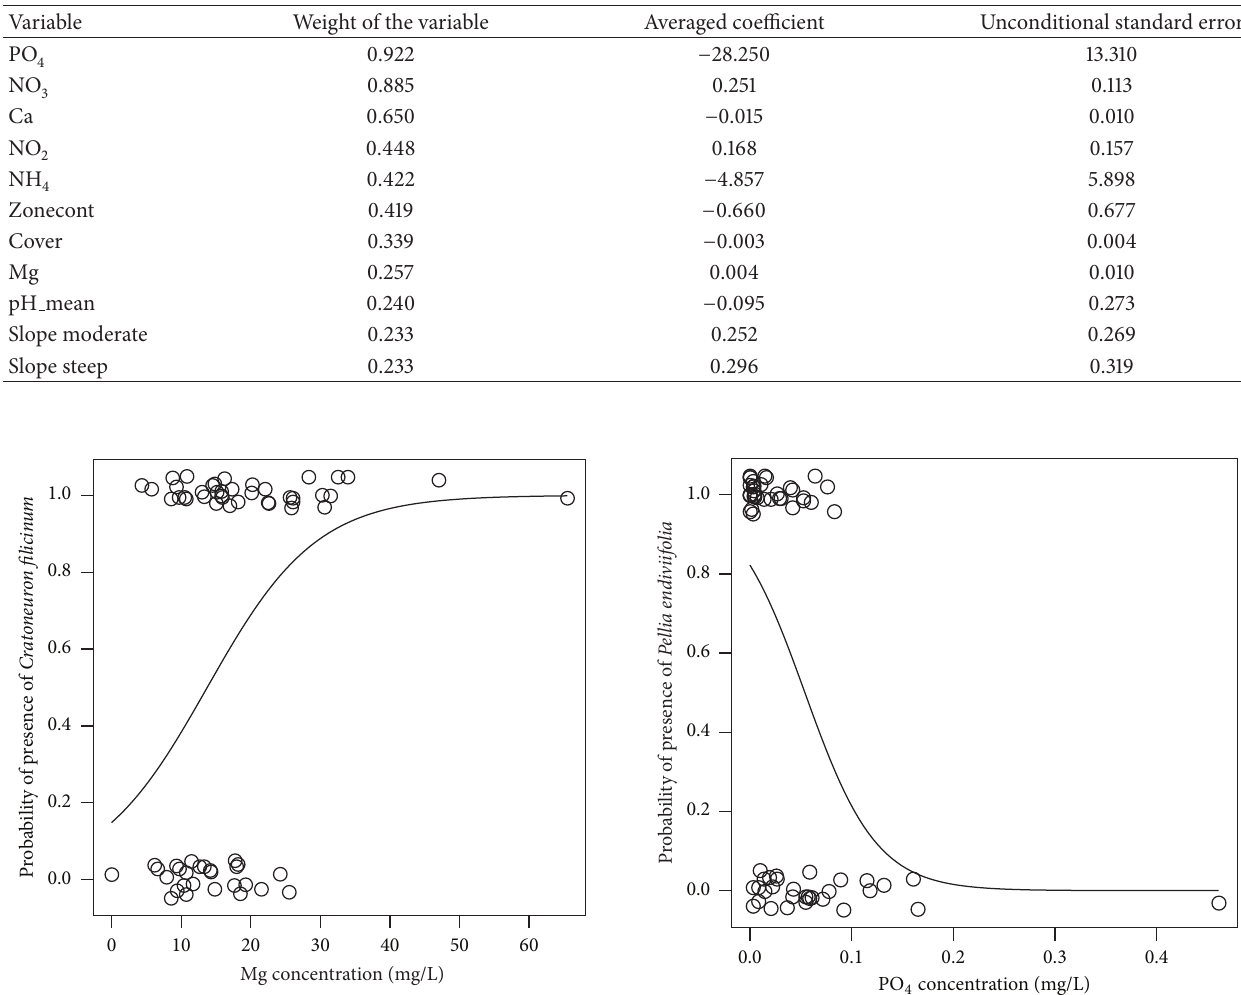
Table 7: Results of the AIC stepwise model selection for probability of presence of Pellia endiviifolia showing the best significant variables selected based on their weight using the complete dataset.